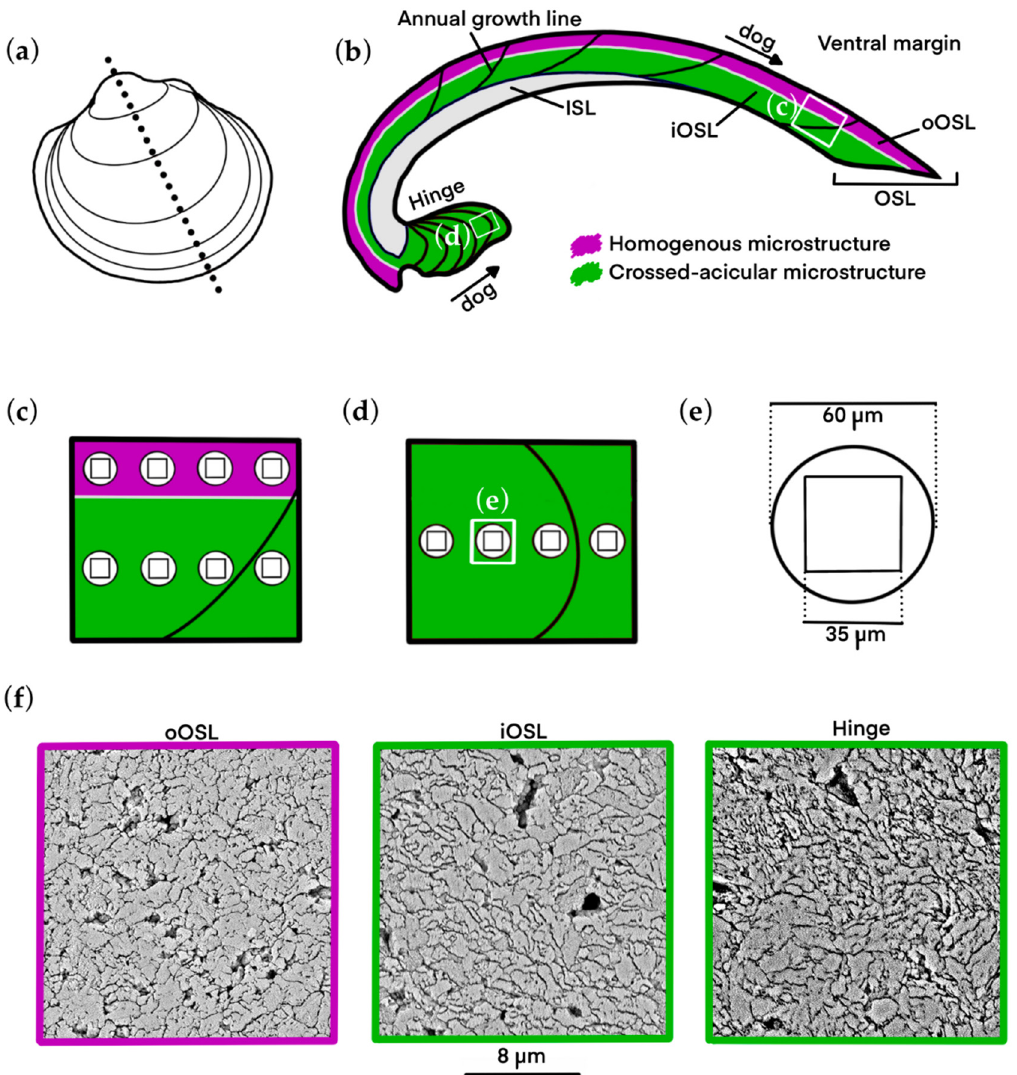
Figure 1. Overview of positions where element chemical and microstructural analyses were performed in shells of Arctica islandica . ( a ) Schematic representation of the left valve showing the cutting axis along (black dotted line). ( b ) Cross-sectioned shell slab showing different shell layers and dominant microstructures. The outer and inner shell layers (OSL, ISL) are separated by the myostracum. The OSL is further subdivided into an outer and inner portion (oOSL, iOSL). Homogenous microstructure (magenta) dominates the oOSL and crossed-acicular microstructure (green) prevails in the iOSL and hinge. The direction of growth (dog) of each shell portion is indicated by arrows. ( c ) An enlargement of panel ( b ) showing the sampling positions for microstructural and in situ chemical analyses in the ventral margin. ( d ) An enlargement of panel ( b ) showing the sampling positions for microstructural and in situ element chemical analyses in the hinge. ( e ) Schematic representation of a laser spot (diameter = 60 µm) for in situ chemical analysis and a SEM image (square of 35 µm). ( f ) Microstructure examples: HOM and CA in the ventral margin, and CA in the hinge. The scale underneath applies to all SEM images.